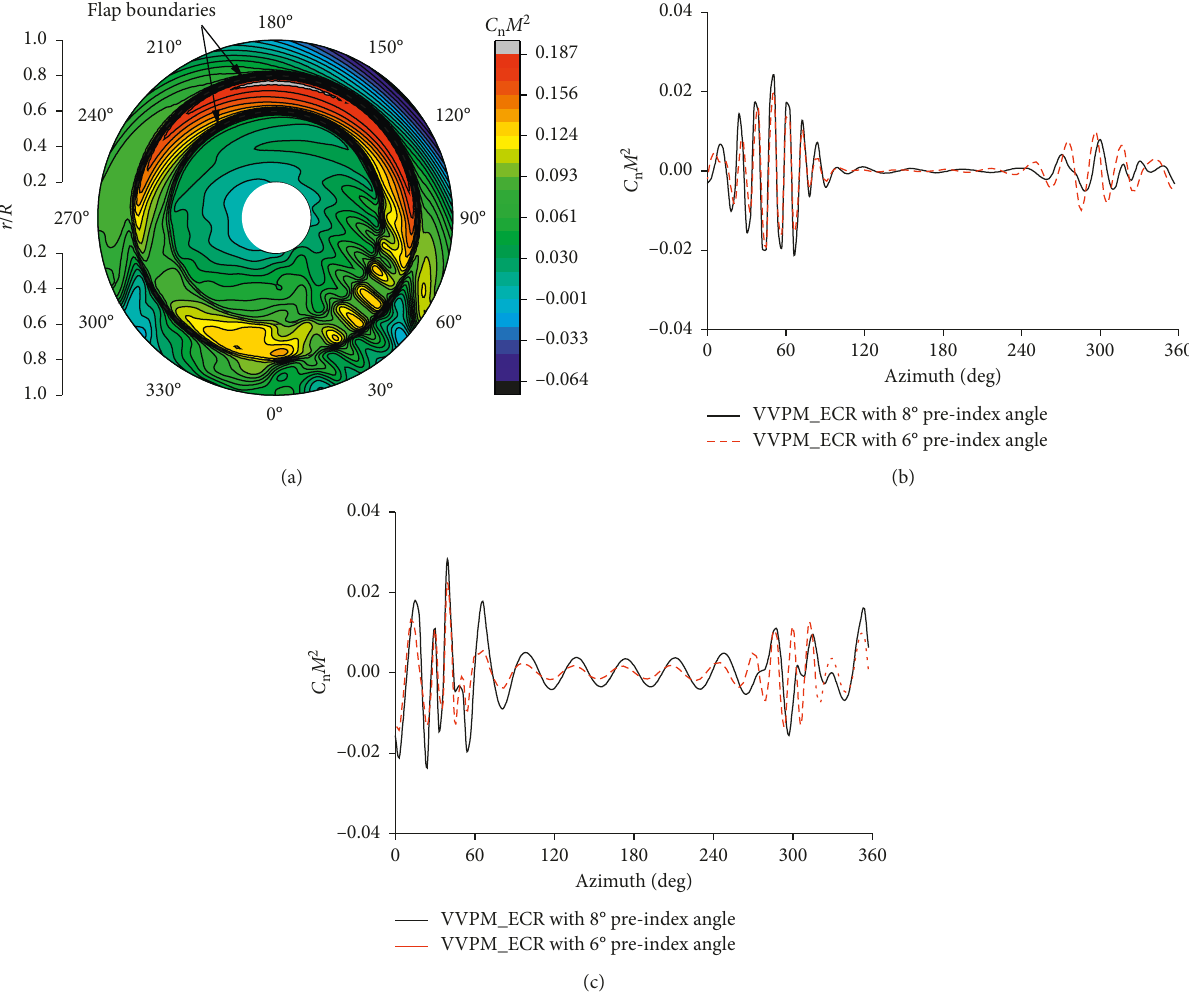
Figure 10: BVI airloads of ECR with 8 ° pre-index angle. (a) Disc airloads distribution; (b) high-frequency ( > 10/rev) section normal force C M 2 at 70% span location; (c) high-frequency ( > 10/rev) section normal force C n